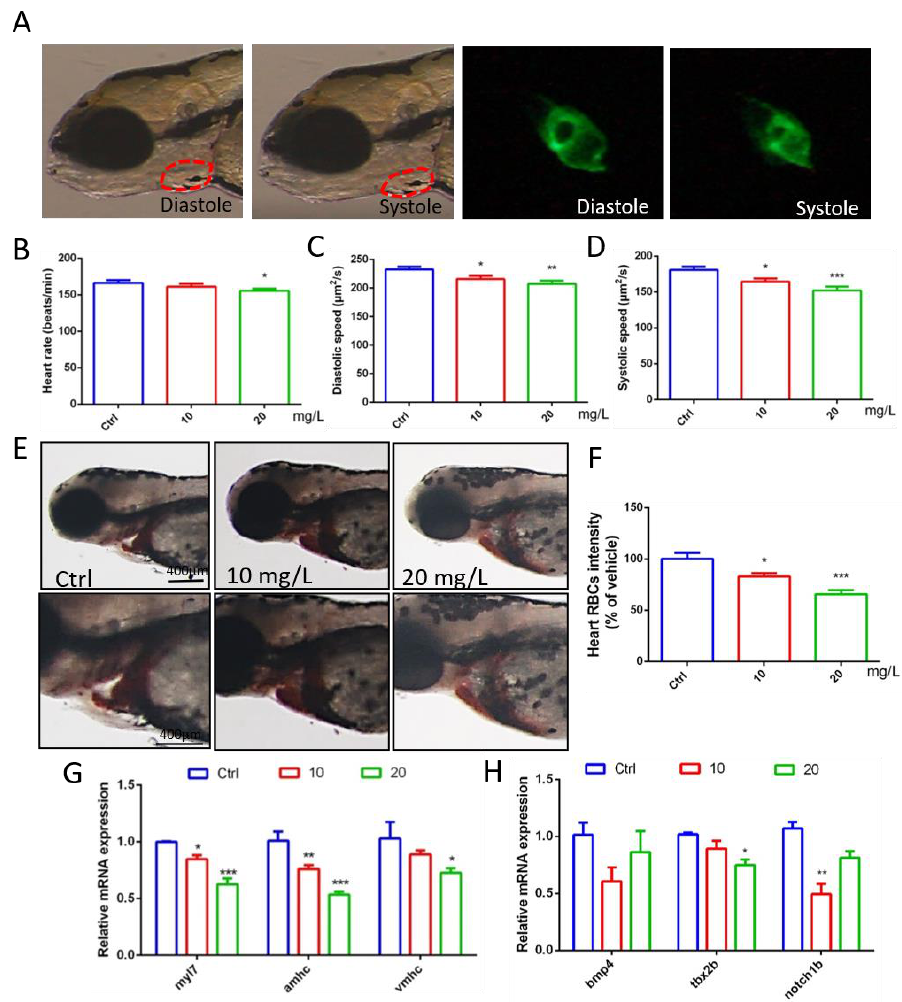
Figure 2. Abnormal gene expression and cardiac dysfunction in zebrafish exposed to 6-BA at 72 hpf. ( A ) Diastolic and systolic states of larval hearts under bright field and green fluorescence. ( B – D ) Statistical results of larval cardiac function parameters, including heart rate, diastolic velocity, and systolic velocity. ( E ) Image of zebrafish heart after o-dianisidine staining. ( F ) Quantitative analysis of cardiac staining results. ( G ) Expression of the myocardial regionalization marker genes myl7 , amhc , and vmhc in zebrafish. ( H ) Expression levels of the atrioventricular canal (AVC) marker genes bmp4 , tbx2b , and notch1b in zebrafish. Values are expressed as mean ± standard error (SEM). N = 3. * p < 0.05, ** p < 0.01, *** p < 0.001.